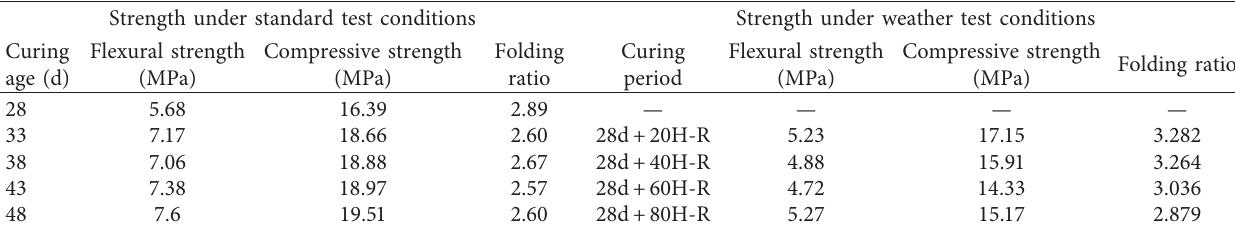
Table 7: Bond strength of the polymer plastering mortar. Bond strength with Curing age (d) mortar block